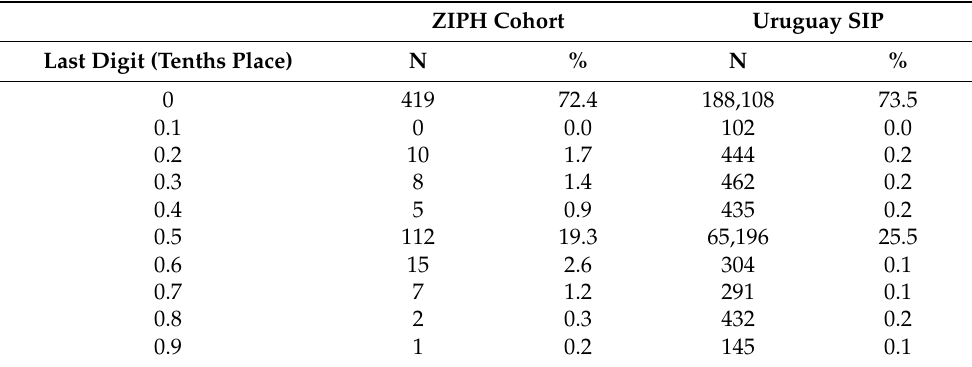
Table 2. Distribution of head circumference measures for the Zika in Pregnancy in Honduras Cohort (2016) and the Uruguay Perinatal Information System (Sistema Inform á tico Perinatal, SIP) Surveillance System (2010 − 2015).